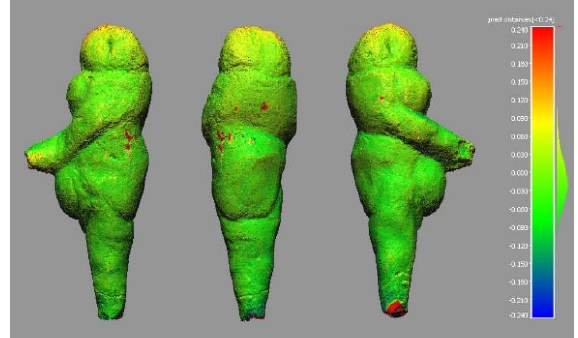
Figure 14. Colour map of the distances between point cloud from SFM and mesh from laser without the points near the laser holes